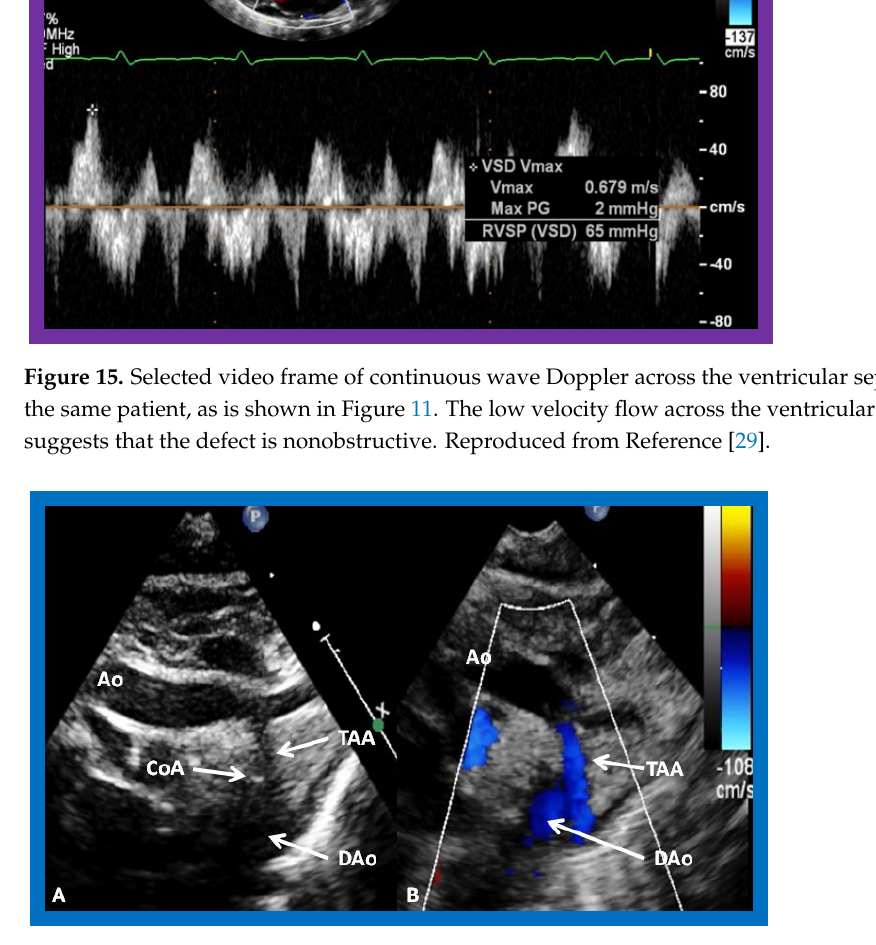
Figure 16. Selected video frames from suprasternal notch views of the aortic (Ao) arch in 2D ( A ) and color flow ( B ) images of a neonate with tricuspid atresia and transposition of the great arteries, demonstrating coarctation of the aorta (CoA) and a hypoplastic transverse aortic arch (TAA) and isthmus. The association of CoA with tricuspid atresia, plus transposition of the great arteries, is well known. DAo, descending aorta. Reproduced from Reference [29].